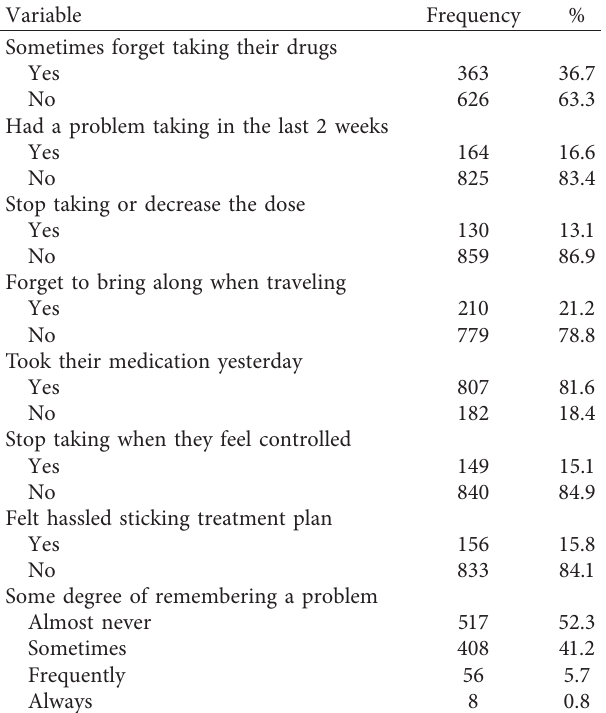
Figure 1: Hypertensive patient’s level of treatment adherence in Central Ethiopia,